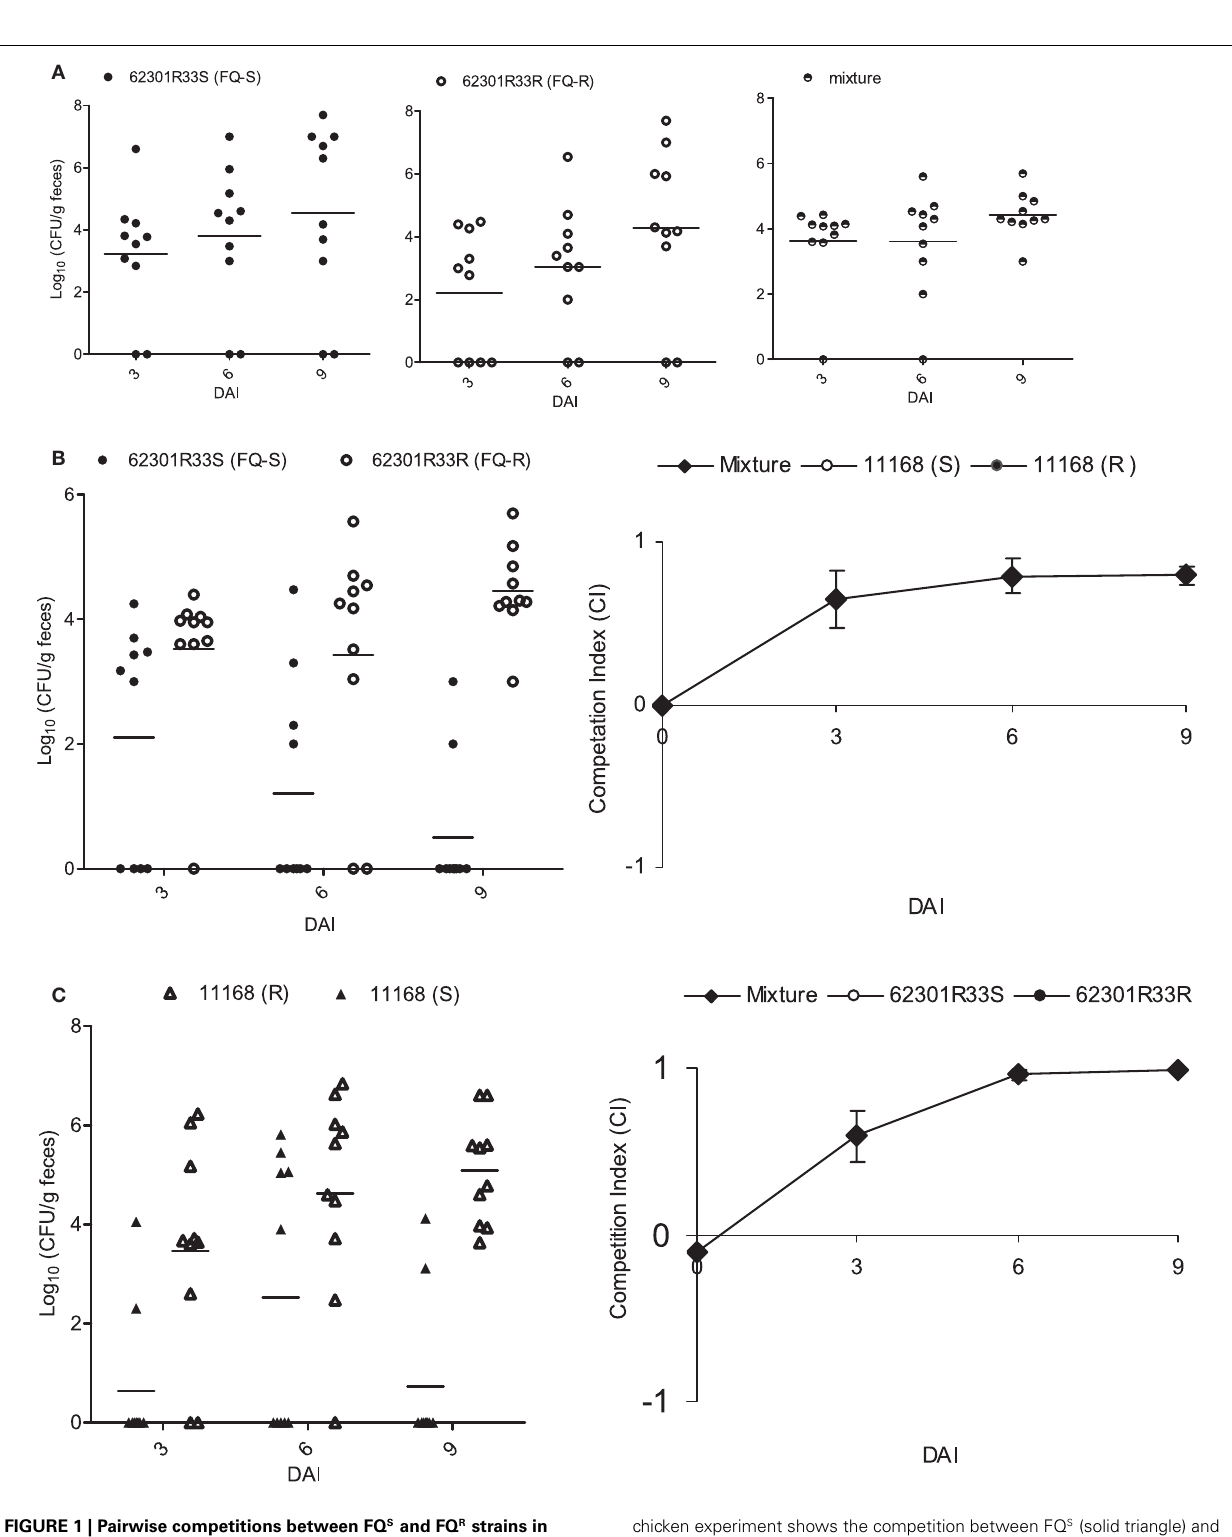
FIGURE 1 | Pairwise competitions between FQ S and FQ R strains in chickens using isogenic pairs of 62301R33S/62301R33R (A,B) and 11168(S)/11168(R) (C). (A) The colonization level of total Campylobacter in three groups of chickens that were inoculated with 62301R33S (solid circle), 62301R33R (open circle), or 1:1 mixture of the two stains. (B) Differential enumeration of FQ S (solid circle) and FQ R (open circle) Campylobacter in the group inoculated with a mixture of 62301R33S and 62301R33R. (C) A second